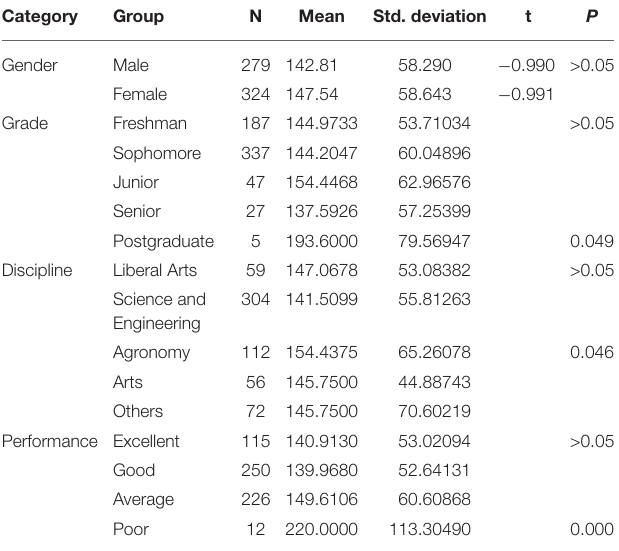
TABLE 1 | The SCL-90 scores of SFD.